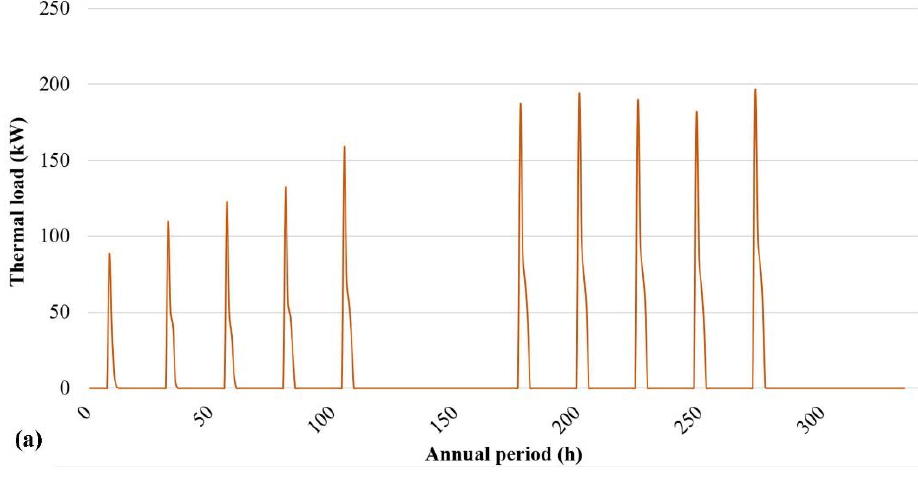
Figure 8. Figure 8. Cont. Figure 8. Cont.